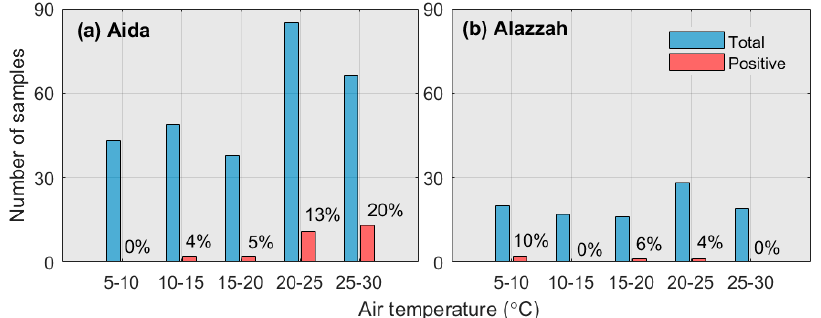
Figure 1. Relationship between air temperature and rooftop-tank water testing results for ( a ) Aida Camp and ( b ) Alazzah Camp. Air temperature values represent the 72-h average preceding the time of sample collection; averages were calculated with data available for Jerusalem from timeanddate.com. Percentage (%) of total samples in each temperature group that tested positive are shown next to the bars.